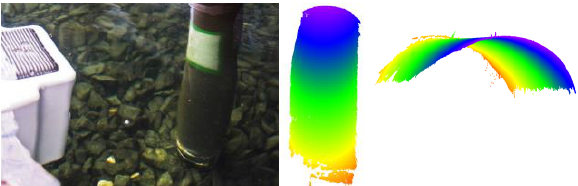
Figure 12. Underwater measurement of a pipe (left), color coded 3D representation of the measurement result (right)